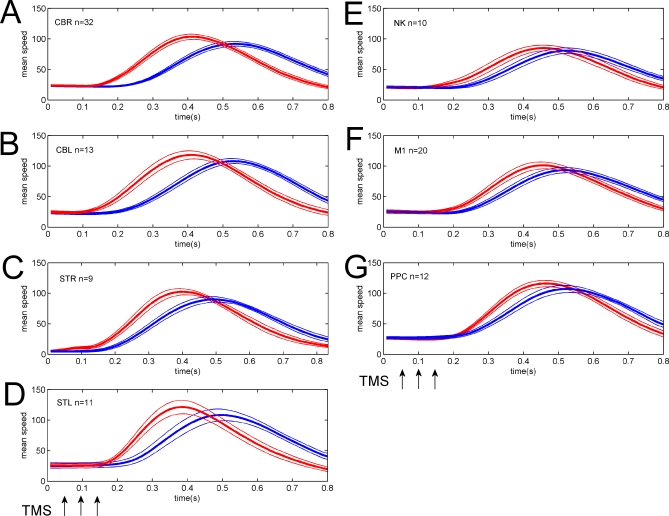
Group Speed Profiles for TMS Trials (Red) and Non-TMS Trials (Blue)Each panel shows the group average speed profile (±1SEM) for 800 ms after cue onset. The time of TMS stimulation is indicated by the three arrows. (A–D) Startle effects: TMS over cerebellum during rightward movement (A: n = 32); during leftward movement (B: n = 13), or with a stationary start position (C: note zero intial velocity; n = 11) leads to a reduced reaction time and increased peak speed very similar to that induced by startle stimulation (D: with TMS over the ear, n = 4, or with sound stimuli, n = 7). (E–G) Control stimulation sites with TMS over the ipsilateral neck (E: n = 10), contralateral hand area of motor cortex (F: n = 20) or contralateral posterior parietal cortex (G: n = 12); the startle effects are smaller with slighter reduction of reaction time and increase of peak speed.